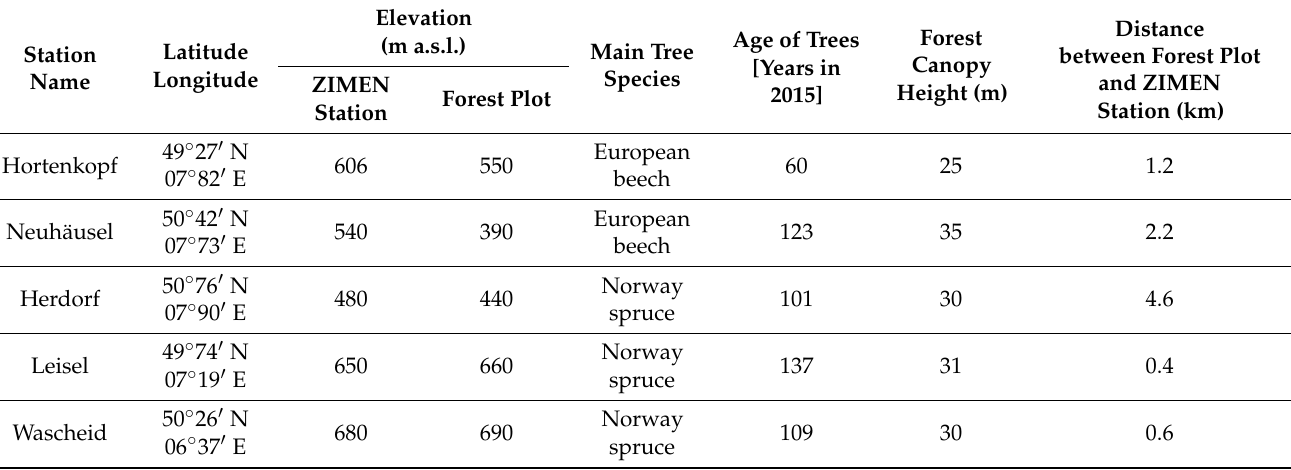
Figure 1. Geographical location (red circles) of the twinned forest sites (Level II) and nearby meteoro- logical and air quality monitoring ZIMEN stations in Rhineland-Palatinate (Germany) [46,47]. Table 1. The main characteristics of ZIMEN stations and their nearby ICP Forest Level II forest plots [47].